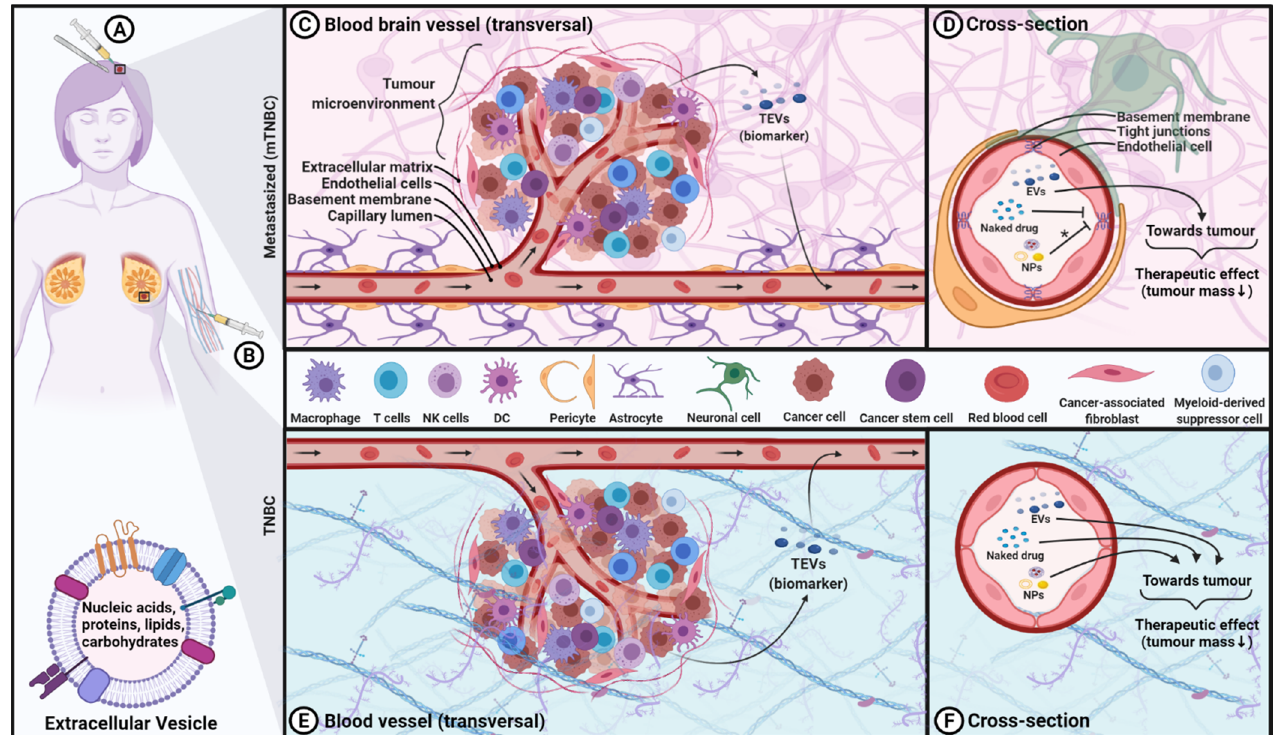
Figure 1. Summary of the potential applications of extracellular vesicles (EVs) in triple-negative breast cancer (TNBC). Panels ( A , B ) show the conventional surgery (panel A ) for the treatment of TNBC metastasized to the brain and the proposed treatment approach via systemic administration of EVs panel ( B ). Panel ( C ) depicts a transversal view of a brain blood vessel in the tumour microenvironment of TNBC metastasized to the brain, highlighting that the TNBC-derived tumour-EVs (TNBC-TEVs) released into the blood could be used as biomarkers for diagnostic/prognostic purposes. Panel ( D ) shows a cross-section view of the same blood vessel, illustrating that only EVs are capable of crossing the blood–brain barrier (BBB) to target metastasized TNBC in the brain, but not naked drugs and conventional synthetic nanoparticles (NPs). Panel ( E ) illustrates the diagnostic/prognostic potential of TNBC-TEVs for none-metastatic TNBC in the mammary glands or TNBC metastasized to other organs outside the brain. Panel ( F ) shows that all naked drugs, synthetic NPs and EVs could cross blood vessels to TNBC tumors outside the brain. The diagnostic/prognostic biomarkers of TNBC-TEVs are listed in Table 1 and the therapeutic molecules delivered via various EV-NDDS for the treatment of TNBC are listed in Table 2. This figure was created with BioRender.com.